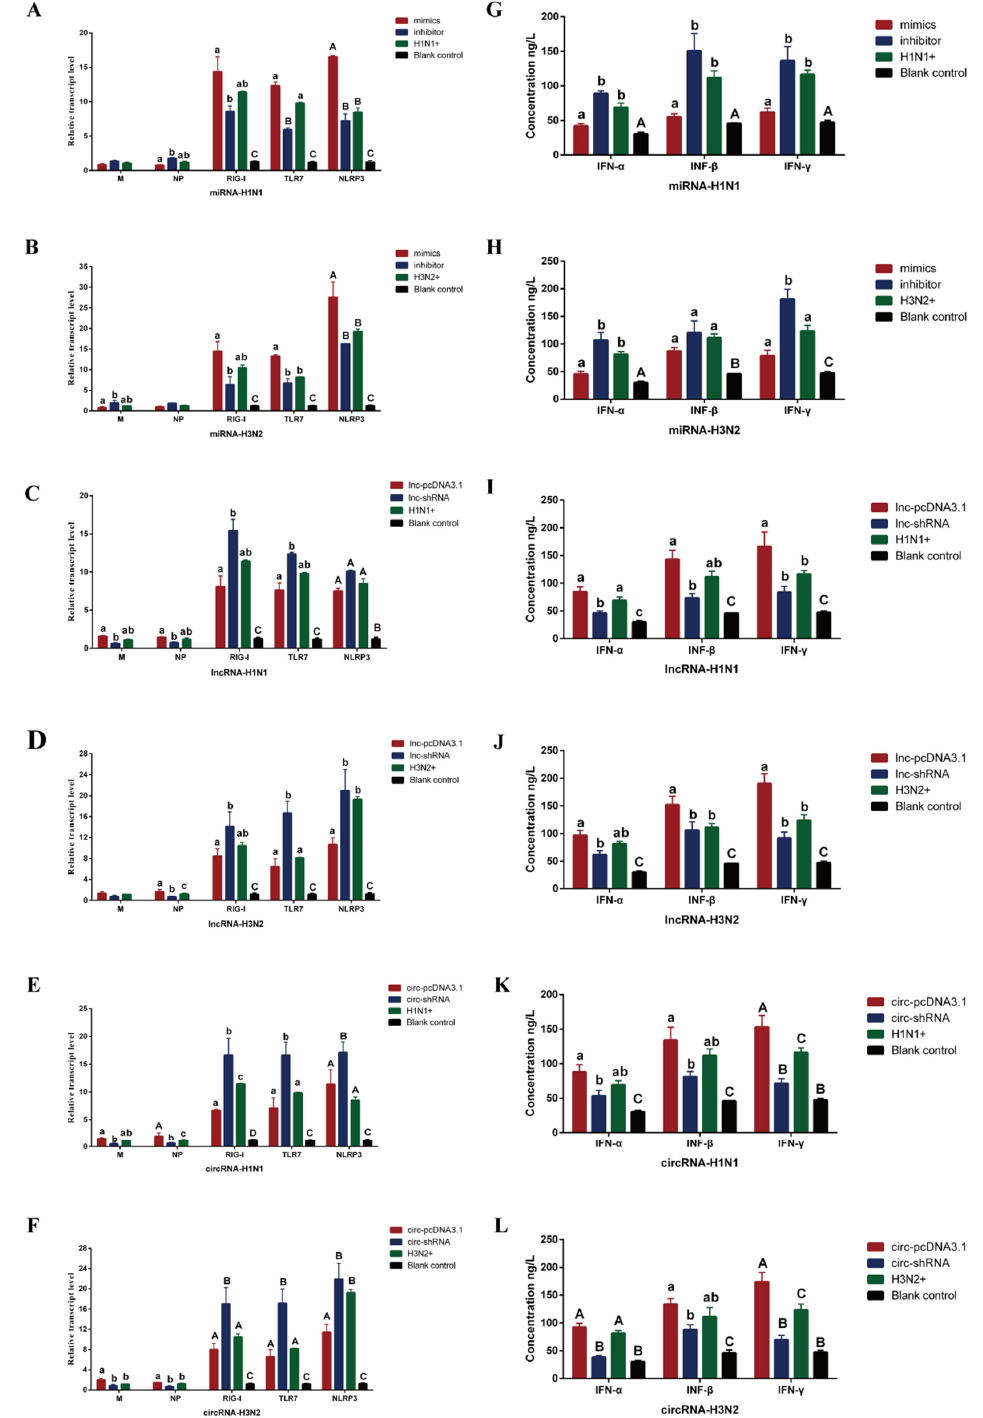
Figure 4. The regulatory role of miR-10391, TCONS_00166432 and novel_circ_0004733 in the process of H1N1 and H3N2 infecting 3D4/21 cells. ( A – F ) represents the effect of miR-10391, TCONS_00166432, and novel_circ_0004733 on the expression levels of viral genes and host genes in 3D4/21 cells infected by H1N1 and H3N2, respectively. ( G – L ) represents the effect of miR-10391, TCONS_00166432 and novel_circ_0004733 on the secretion of cytokines in the supernatant of 3D4/21 cells infected by H1N1 and H3N2, respectively. Different lowercase letters indicate significant differences ( p < 0.05), and different capital letters indicate significant differences ( p <